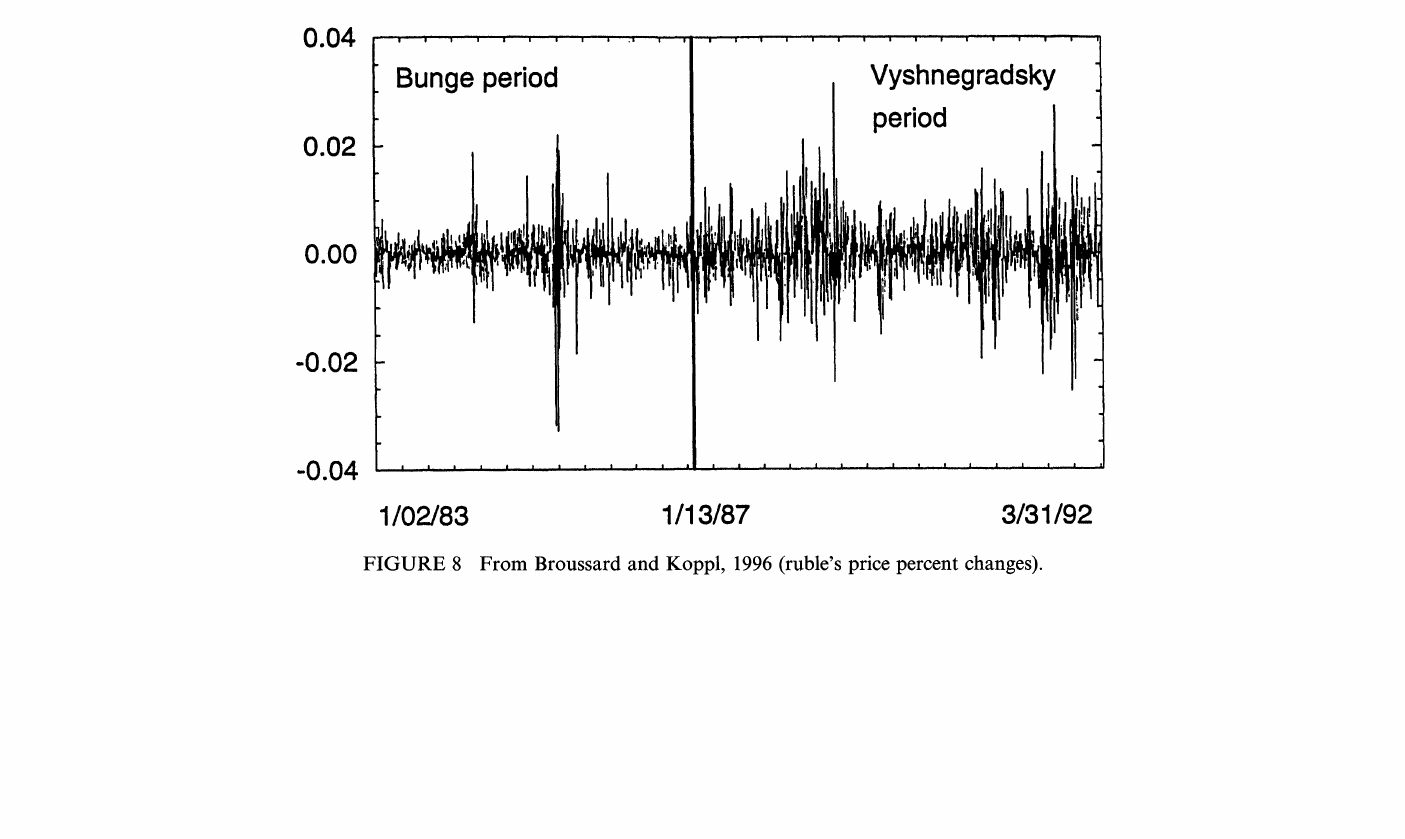
FIGURE 8 From Broussard and Koppl, 1996 (ruble’s price percent